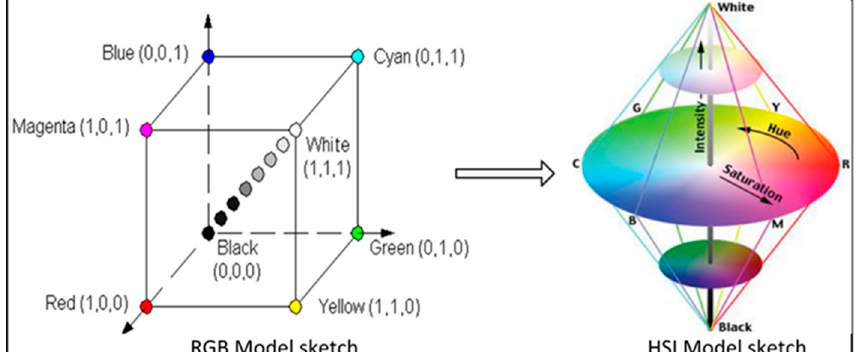
Figure 4. Diagram of the color space model from Red-Green-Blue (RGB) to Hue-Saturation-Intensity (HSI).